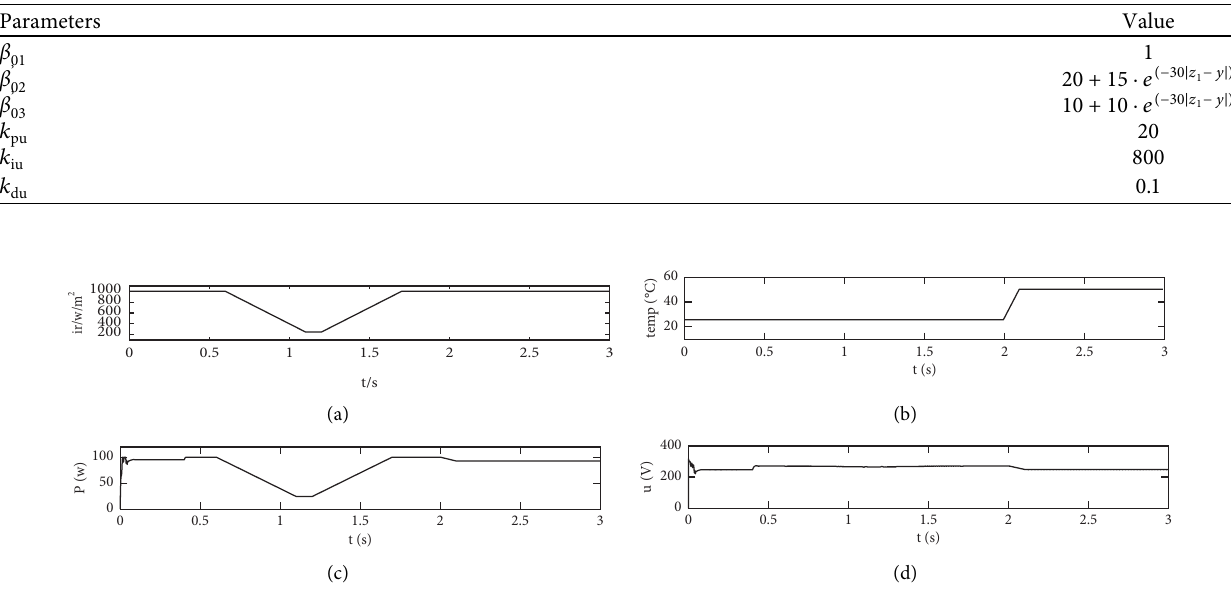
Figure 4: Setting curve of light intensity and temperature change.